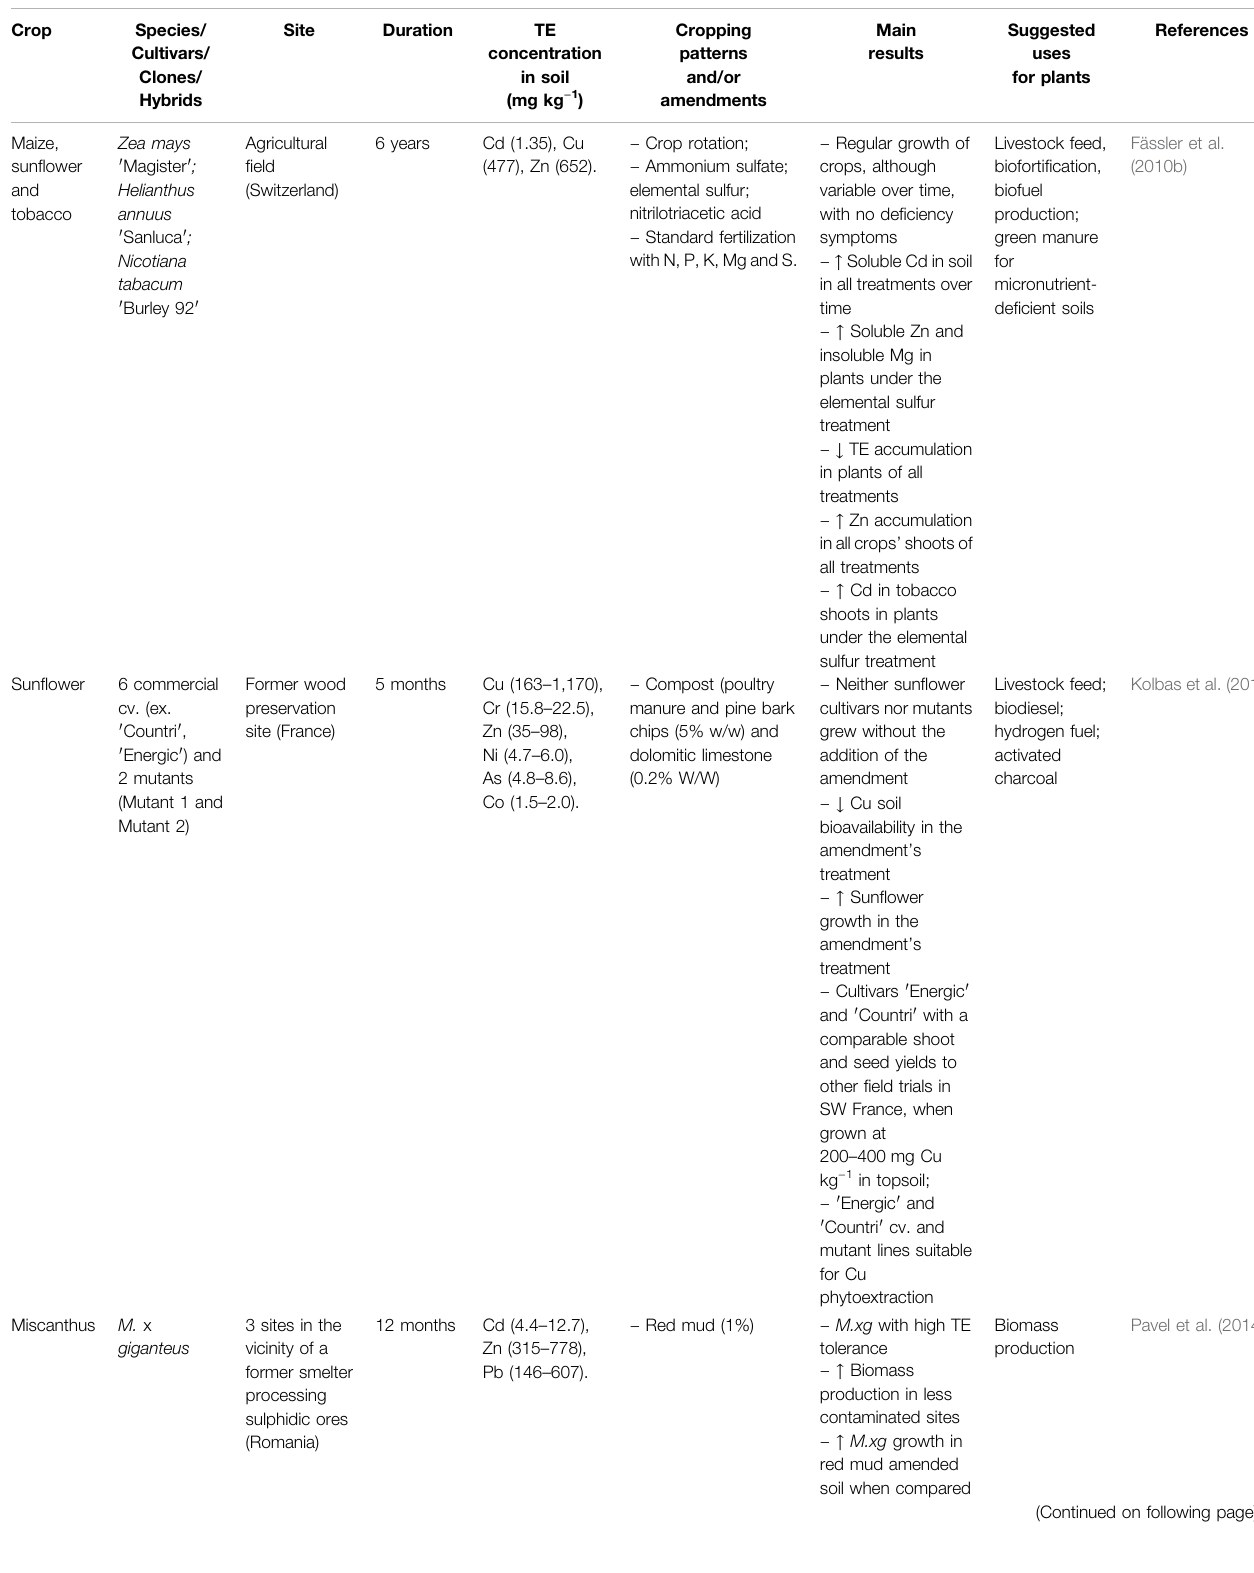
TABLE 4 | Examples of fi eld trials with economically valuable crops under different cropping patterns and/or amendments